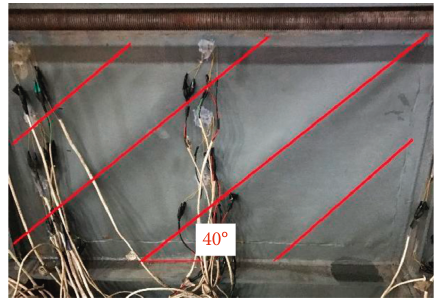
Figure 5: Formation of tension strips in infill steel plate.